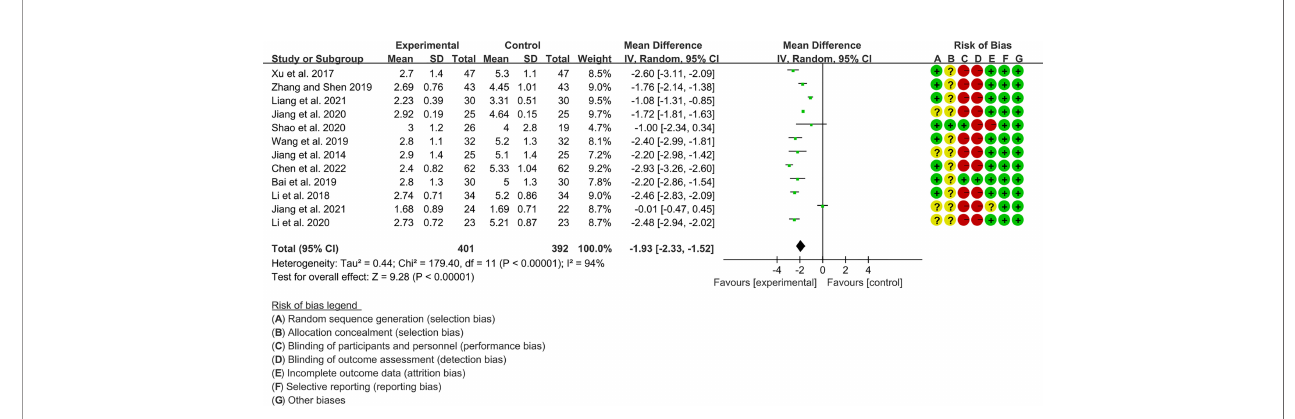
FIGURE 4 | The results of ESSPRI.